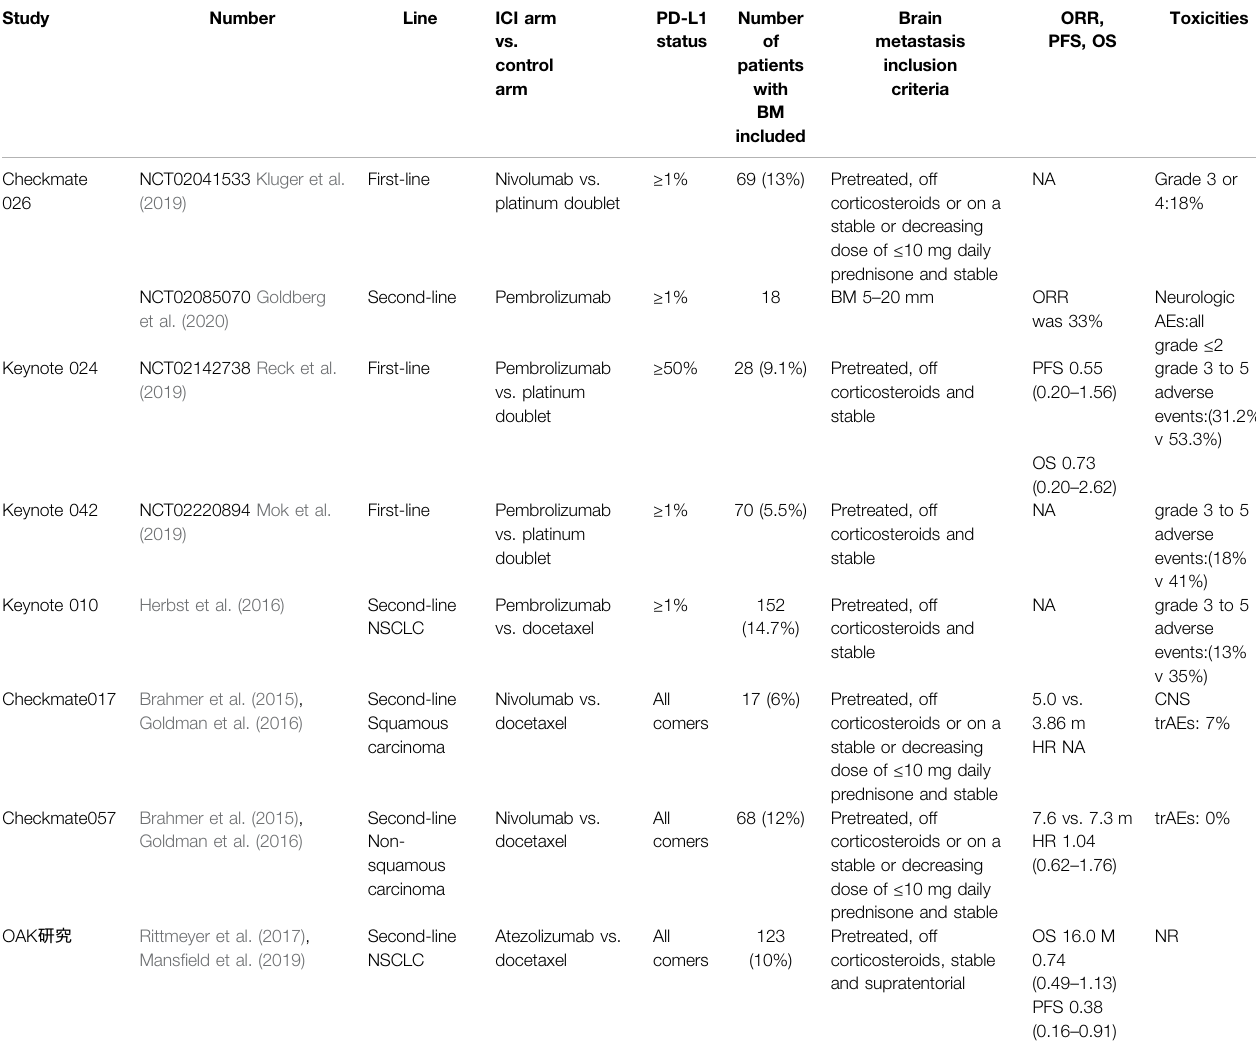
TABLE 1 | Clinical investigations of Immunotherapy monotherapy in the treatment of NSCLC patients with brain metastases.